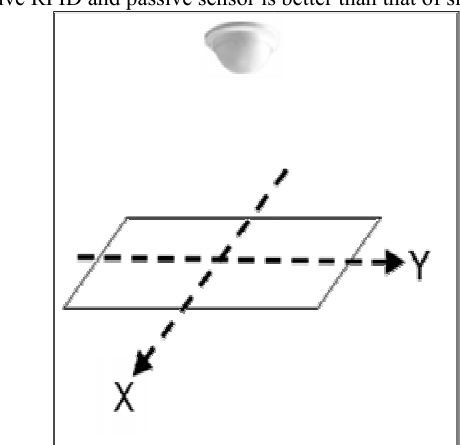
Figure 7. Experimental outline